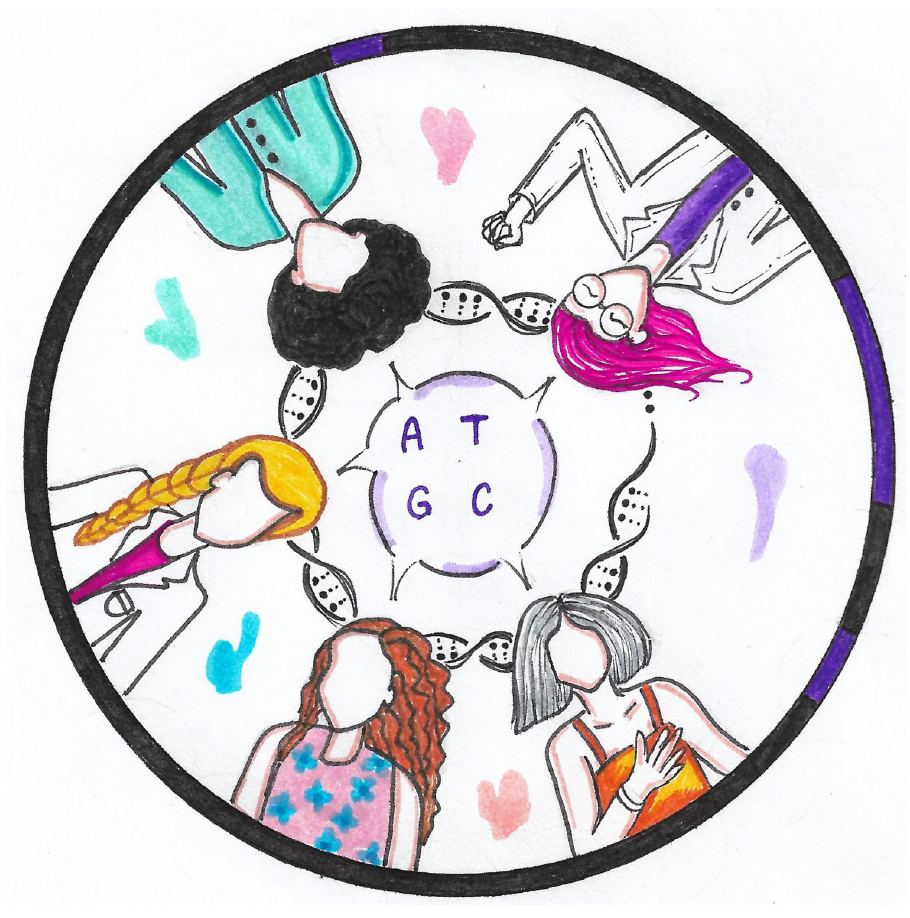
Fig 4. Empower other women through solidarity between them. A group of women joined together by common interests (Illustrated by Jose Faustino